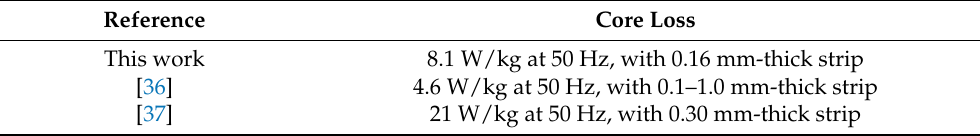
Figure 4. Variation of core losses with applied magnetic flux. Table 6. Comparison of core loss reported for pure iron in the earlier